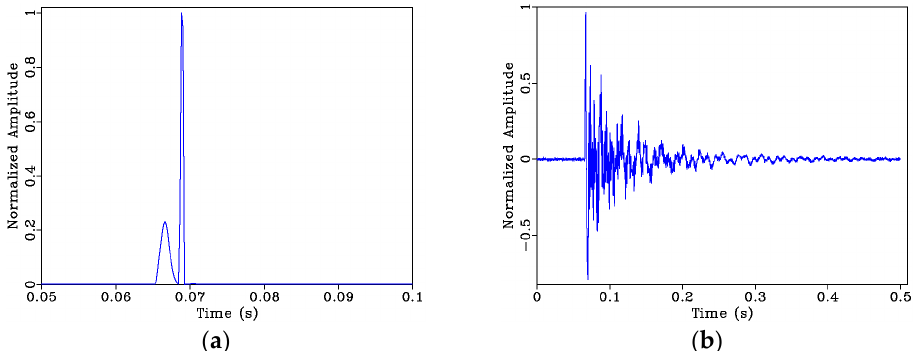
Figure 10. ( a ) Sample of a typical hammer impact signal and ( b ) sample of a typical vibration re- sponse